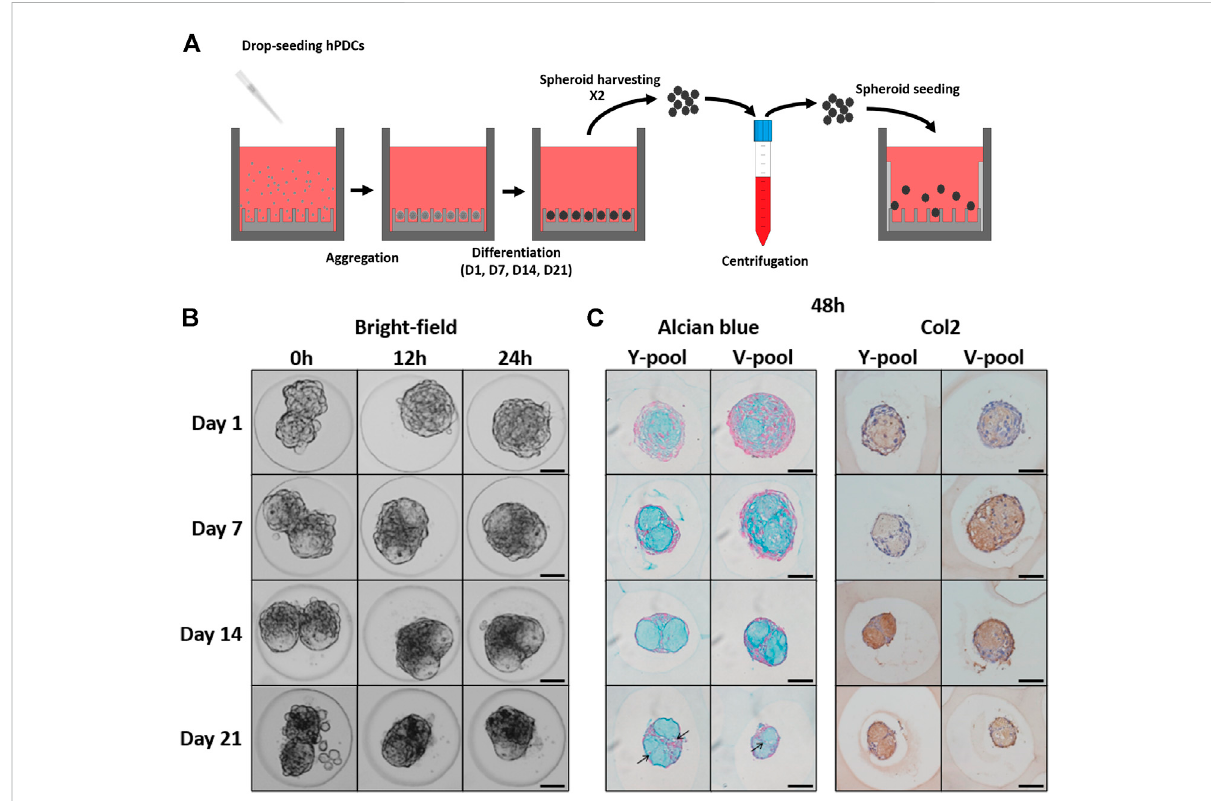
FIGURE 4 Spheroid fusion assay. (A) Schematic overview of the experimental procedure to obtain spheroid pairs. The main steps are cell seeding, cellular aggregation, differentiation,harvesting/centrifugation,and spheroidseeding. (B) Time-lapse images ofthemorphological responseduring spheroid fusion for all different maturation stages of the Y pool. (C) After 48 h, the fused constructs were stained for Alcian Blue (AB) and Collagen Type II (Col2). Scale bars: 50